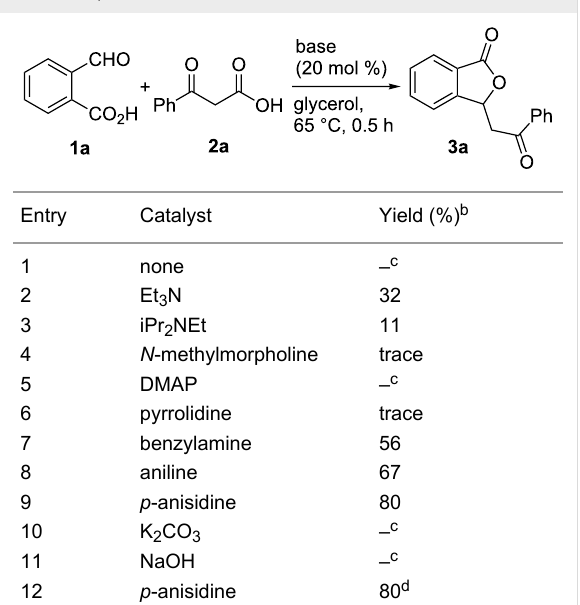
Table 1: Optimization of the reaction conditions a